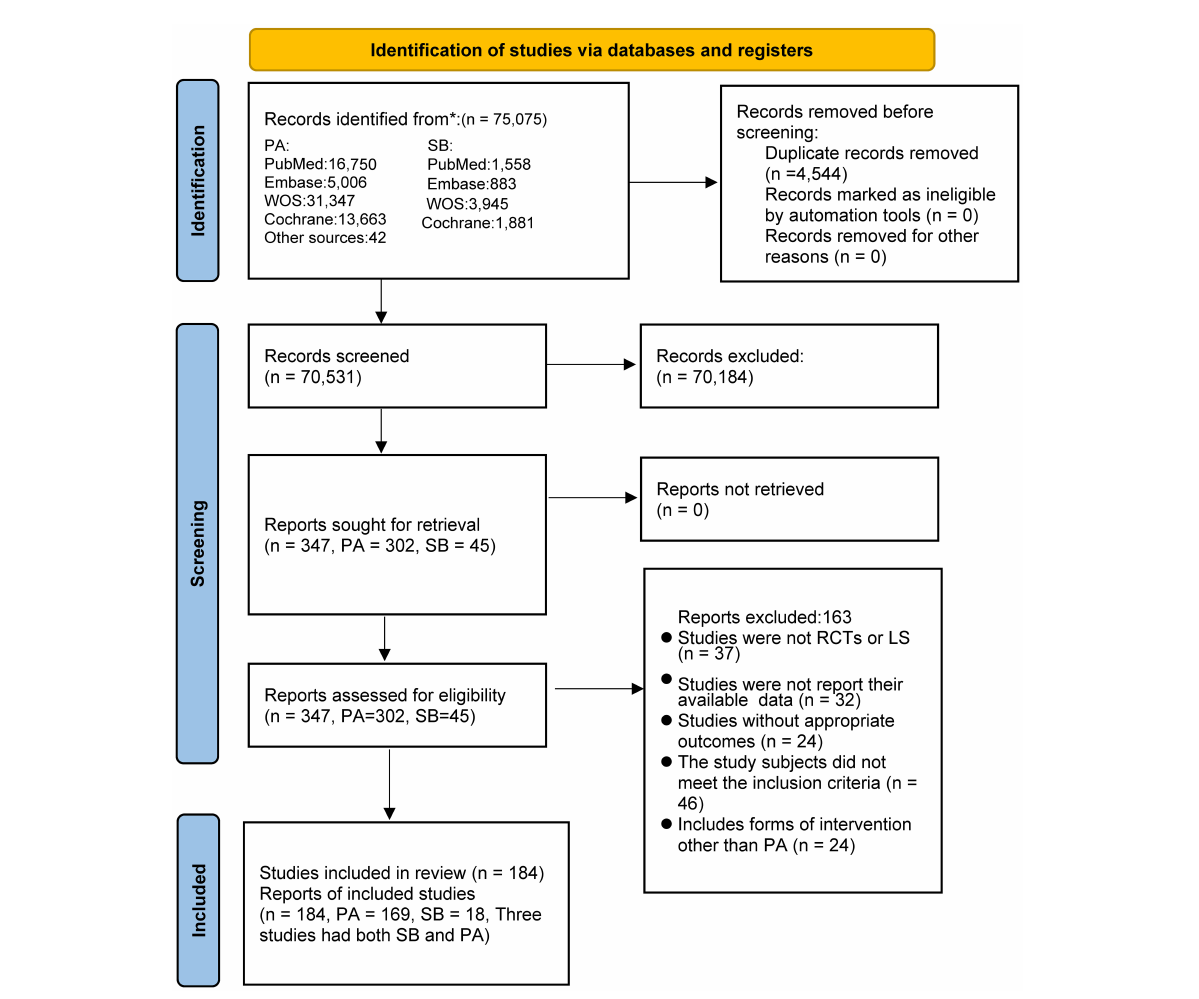
FIGURE1 Literature review flowchart. LS, Longitudinal studies; PA, physical activity; RCT, randomized controlled trial; SB, sedentary behavior; WOS, web of science.